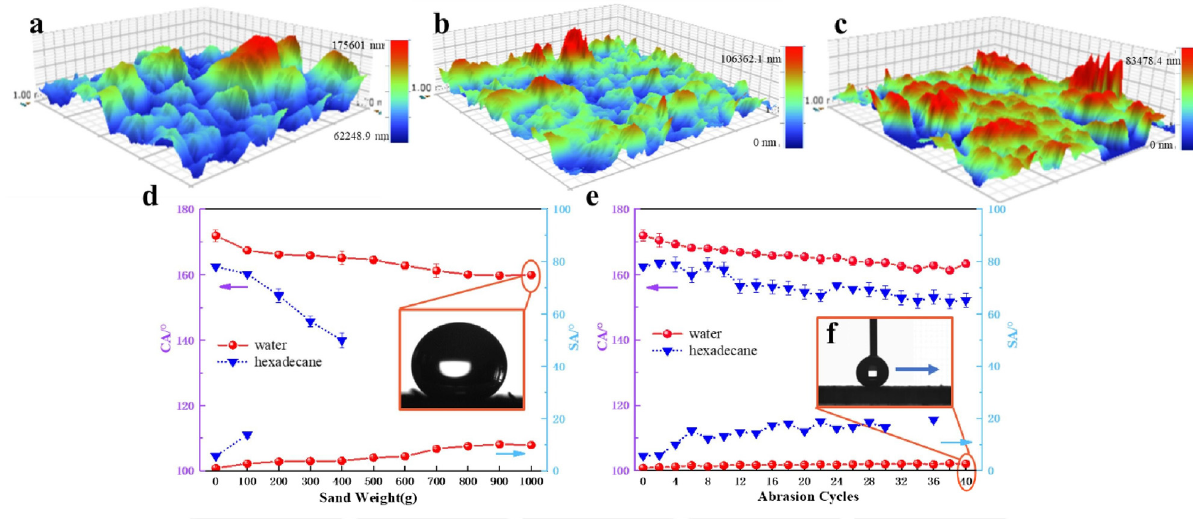
Figure 10: Surface 3D map images after di ff erent abrasion cycles: ( a ) 0, ( b ) 20, and ( c ) 40. CA and SA variation with ( d ) sand impinging weight and ( e ) abrasion cycles [ 156 ] . Reproduced with permission from ref. [ 156 ] ; © 2020